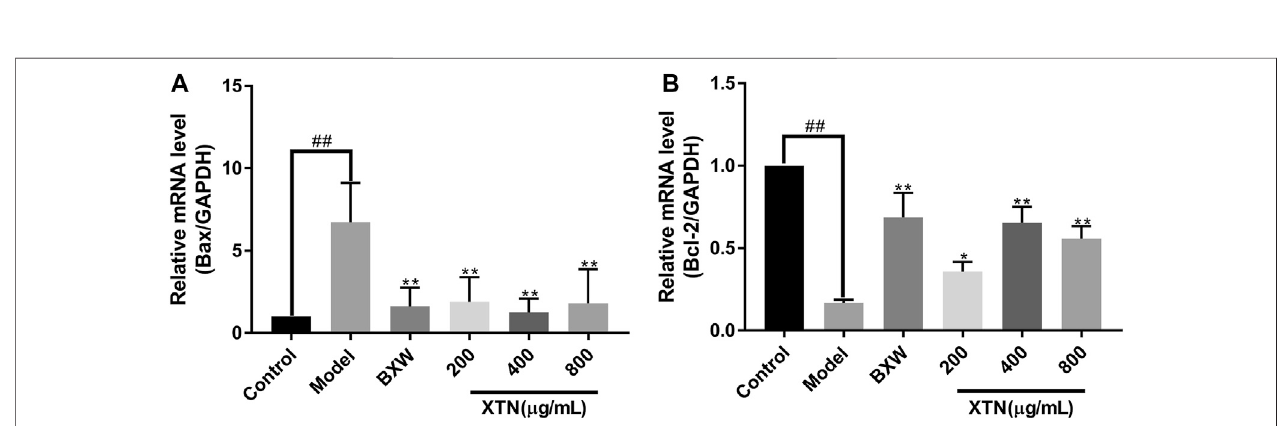
FIGURE5| EffectsofXTNonmRNAexpressionofBaxandBcl-2inAMIrats. (A) RelativemRNAlevelofBax. (B) RelativemRNAlevelofBcl-2.Dataareexpressed as the mean ± standard deviation ( n (cid:2) 6). ## p < 0.01 vs. control group; * p < 0.05, ** p < 0.01 vs. model group.